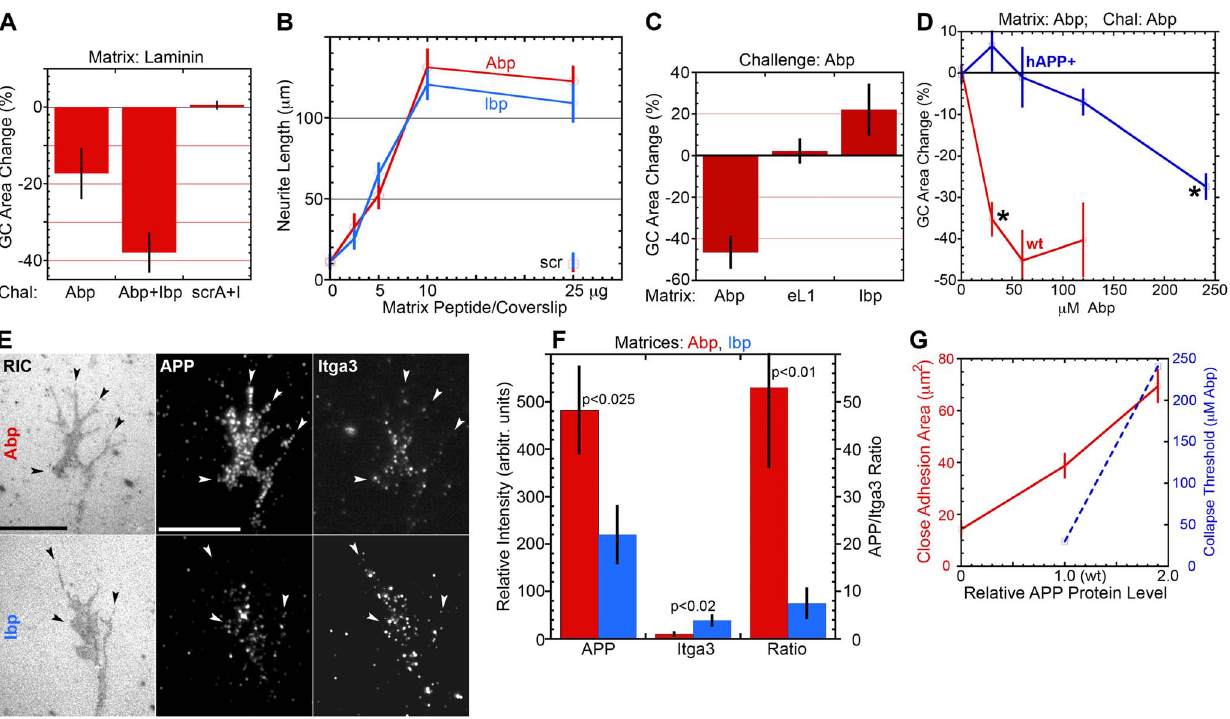
Figure 4. GC adhesion to peptide matrices and adhesion assessment in competition experiments with soluble peptides. A. Wt mouse neurons were grown on laminin and challenged for 10 min with approx. 37 m M each of Abp, Abp plus Ibp or scrambled Abp plus scrambled Ibp (scrA + I). Peptide-induced GC detachment is shown as area reduction (mean % change 6 s.e., relative to area before challenge; n $ 9). Student’s t tests were: for Abp vs. Abp + Ibp and for Abp vs. scr A + I, , 0.05; for Abp + Ibp vs. scrA + I, , 0.0001. B. Neurite length (mean 6 s.e.) at 24 h in culture, as a function of peptide deposition. Matrix peptide/coverslip, amount used for coating. scr, data points for scrambled Abp and Ibp. C. Wt mouse neurons were grown on Abp, eL1 or Ibp and challenged with 75 m M soluble Abp for 10 min. Graph shows Abp-induced change in GC area (mean % change 6 s.e.). GC collapse (p , 0.001; n $ 4) was observed only on Abp (Ibp was not significantly different from eL1). D. Comparison of wt and hAPP + GCs in collapse assays on Abp (10 min challenge). GC area change (mean % 6 s.e.) is shown as a function of Abp concentration applied. Asterisks mark the lowest Abp concentrations triggering significant collapse (threshold p=0.05; actual significance, p # 3.0E-5). E. RICM and TIRF microscopy of wt GCs (grown for 24 h on Abp or Ibp) fixed, permeabilized and labeled with anti-APP and anti-Itga3. Close adhesions are co-extensive with clustering of APP and Itga3 on Abp and Ibp, respectively (arrow heads). Bars, 10 m m. F. Fluorescence intensity (mean 6 s.e., n=6) of anti-APP and anti-Itga3, and ratio of these intensities in GCs on Abp (red) and Ibp (blue). Antigen clustering is substrate-specific. Labeling intensities of APP and Itga3 cannot be compared because the antibody affinities are unknown. G. GC close adhesion area (red line; from Table 3) and collapse threshold (dashed blue line; from D) plotted relative to APP protein level (normalized to wt; see Fig. 3).